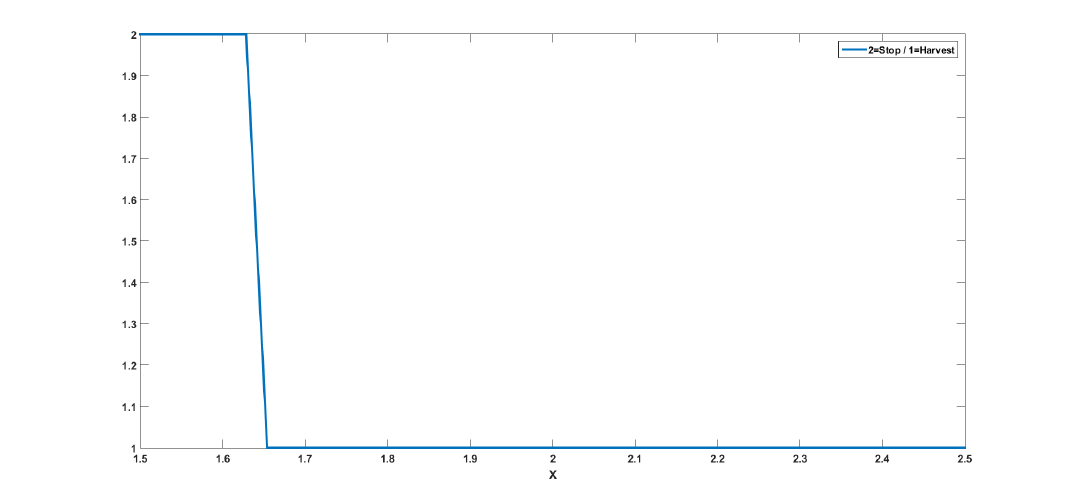
Figure 3. The optimal policy for ( x , p , θ ∈ [ (cid:96) , K ] , ρ , y ) ∈ D 0 in the plane of x . Figure 4. The optimal policy for ( x , p , θ , ρ , y ) ∈ D 0 in the plane of θ